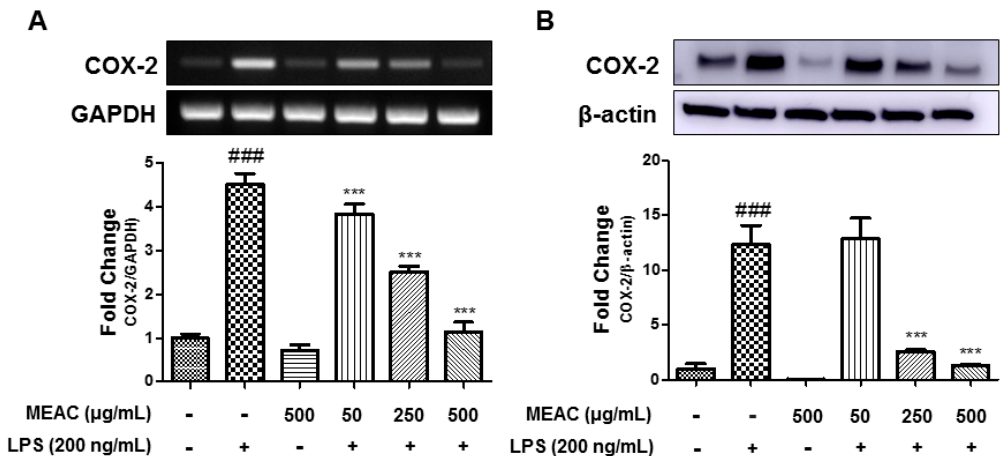
Figure 3. E ff ect of MEAC on LPS-induced COX-2 expressions at mRNA and protein levels in BV-2 Figure 3. Effect of MEAC on LPS-induced COX-2 expressions at mRNA and protein levels microglial cells. ( A ) MEAC-treated prevention of COX-2 expression at mRNA level. ( B ) The treatment in BV-2 microglial cells. ( A ) MEAC-treated prevention of COX-2 expression at mRNA with MEAC protects LPS-stimulated COX-2 expression at protein level. Data are presented as the mean level. ( B ) The treatment with MEAC protects LPS-stimulated COX-2 expression at protein ± SEM. ### p < 0.001 versus control group ( n = 3); *** p < 0.001 versus LPS group ( n = 3). level. Data are presented as the mean ± SEM. ### p < 0.001 versus control group ( n = 3 ); *** p